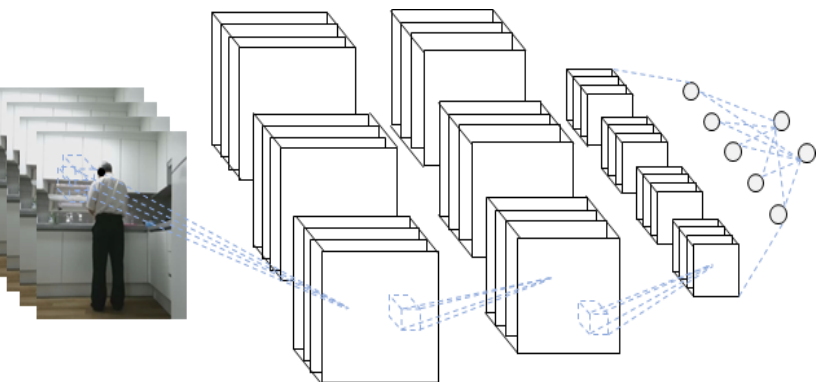
Figure 6. Schematic diagram of the three-dimensional convolutional neural network (3D-CNN) for RGB video input.